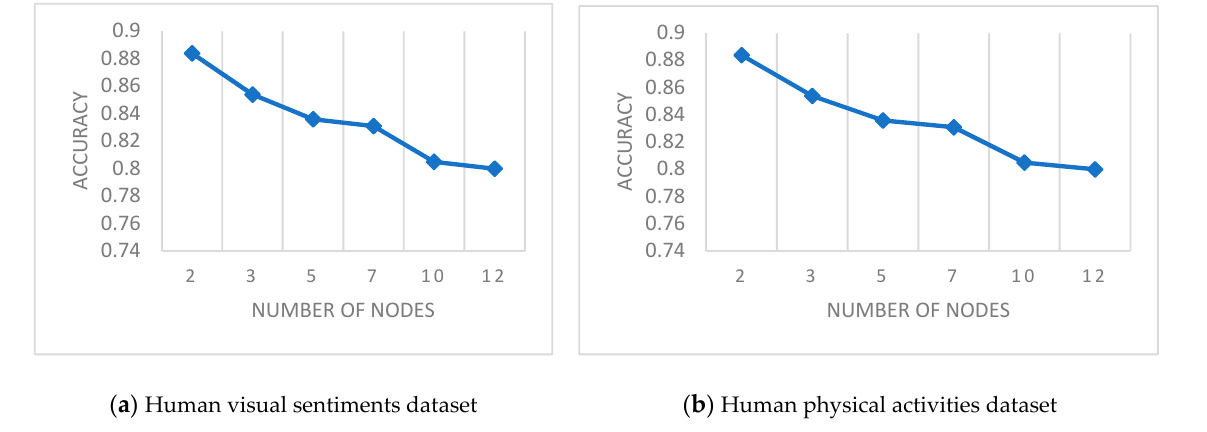
Figure 6. Impact on accuracy by expanding the number of participating client nodes in the FL environment: ( a ) human sentiment; ( b ) human physical activity.